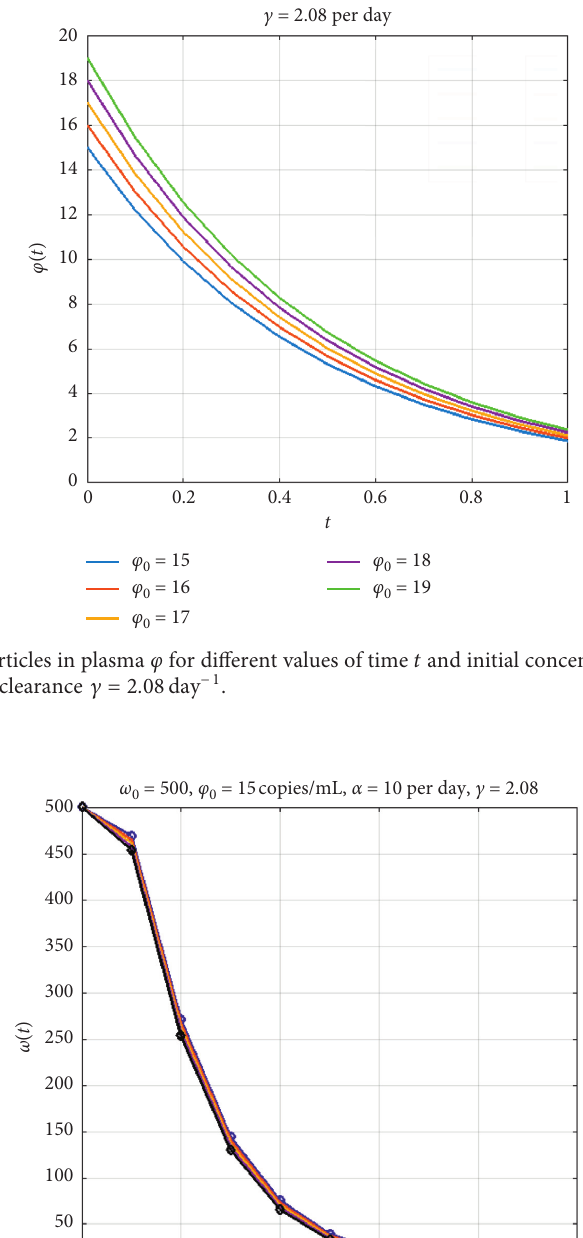
Figure 3: The number of infected cells ω for different values of time t and rate of loss of virus producing cells β with � 500 , φ � 15copies/mL , α � 0 . 10 day − 1 , and c � 2 . 08 day − 1 ω 0 0